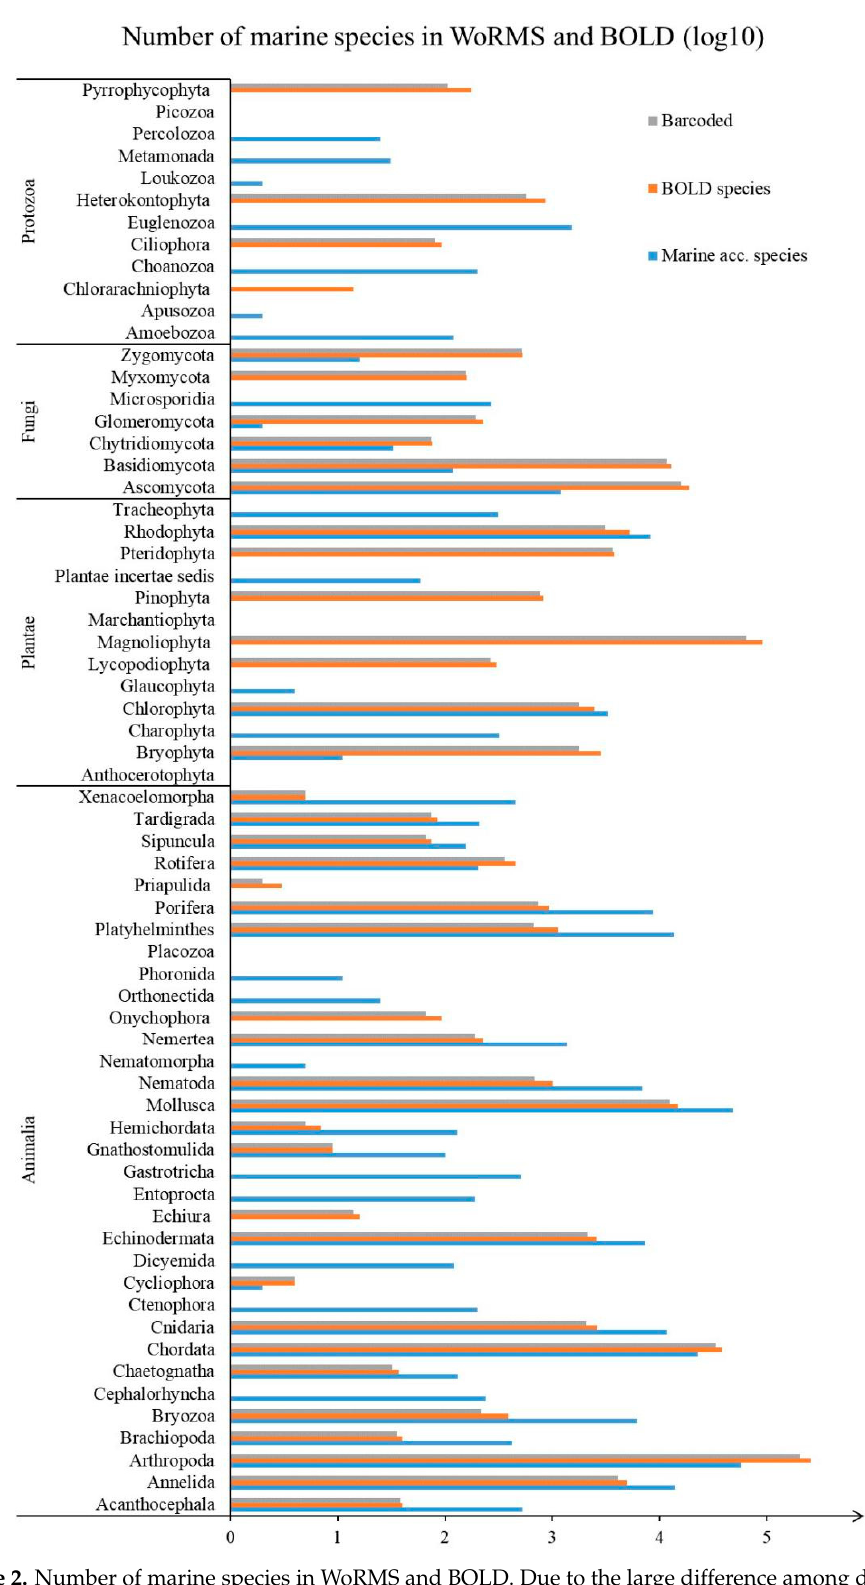
Figure 2. Number of marine species in WoRMS and BOLD. Due to the large difference among different phylum, all data are presented as logarithm of 10. Every unit in Figure 2 represents the difference of 10 times. Marine Acc.species represents the number of accepted marine species within the specific rank in WoRMS; BOLD species represents the number of species in BOLD; Barcoded represents the number of barcoded species in BOLD.